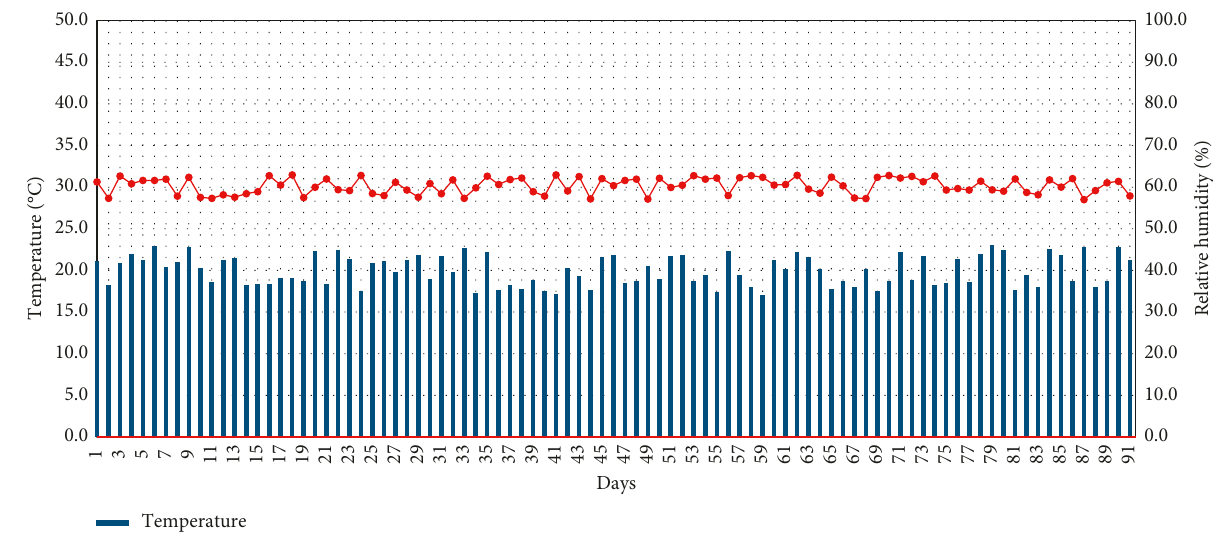
Figure 7: Curing conditions (the remaining part of UHPC